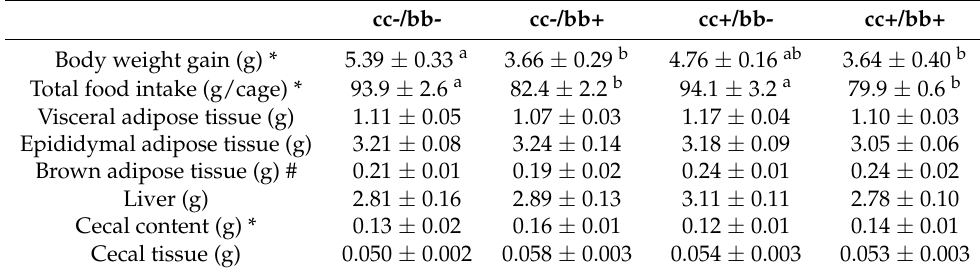
Table 1. Body weight gain, food intake and organ